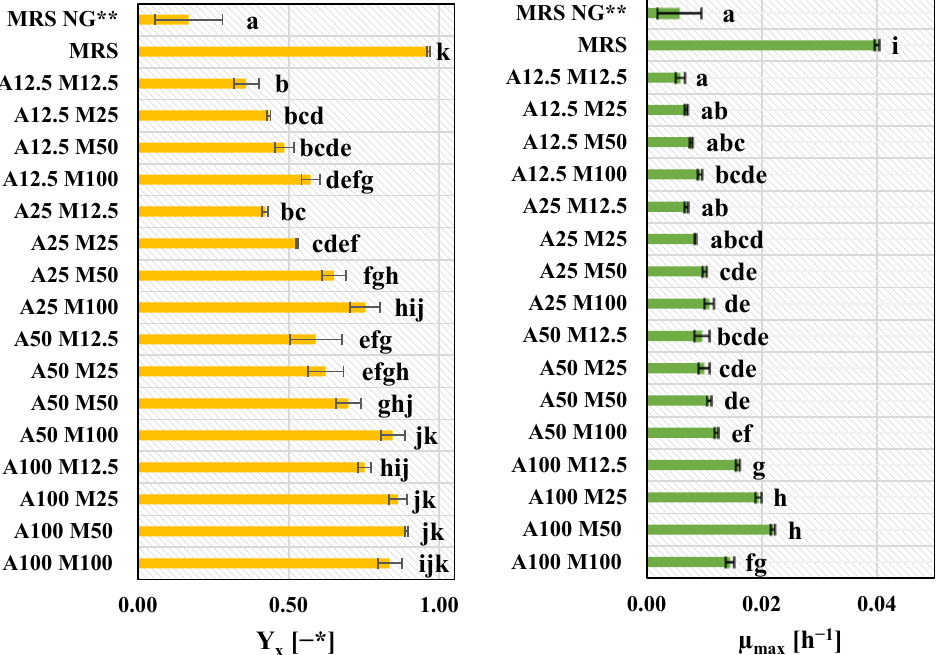
Figure 3. Biomass yield (Y x ) and maximum specific growth rate ( μ max ) for L. plantarum KB2 LAB 03 cultivated on different variants of acid whey-based media. *—Optical Density; **—MRS water-based medium without glucose; A—group of nitrogen sources (yeast extract, peptone K); M—group of mineral sources (ammonium citrate, dipotassium phosphate, sodium acetate, magnesium sulphate heptahydrate, magnesium sulphate tetrahydrate). A100 M100—acid whey medium supplemented with 100% base concentration of group A supplements and 100% base concentration of group M supplements. The following numbers (50, 25, 12.5) indicate supplementation with a certain percentage of the base concentration of group A and M supplements. MRS, MRS no glucose—control, water-based media. The specific concentrations of each component are presented in Section 2.4.1 point of Materials and Methodology section. a–k—results with different letters are significantly different (Tukey’s test, α = 0.05).